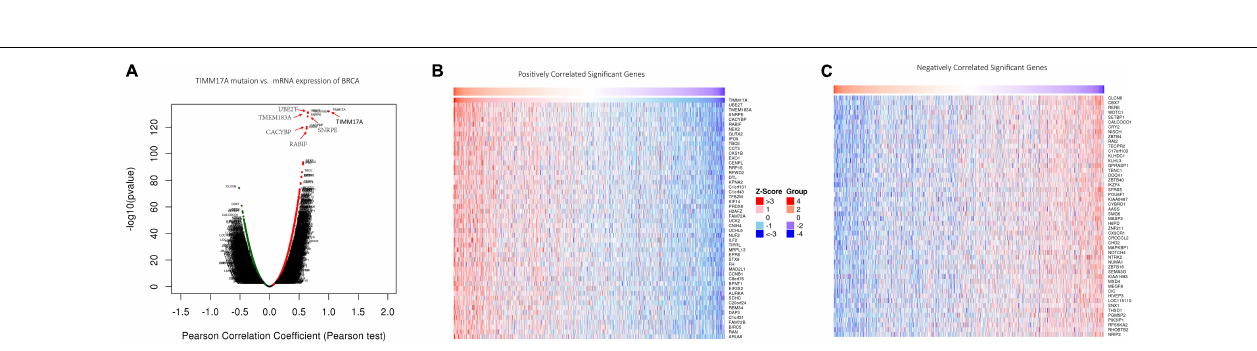
FIGURE 6 | Genes differentially expressed in correlation with TIMM17A expression among breast carcinoma patients (LinkedOmics). (A) Pearson’s correlation analyses to assess the association between TIMM17A expression and that other genes differentially expressed in BRCA. (B,C) Heat maps showing genes positively and negatively correlated with TIMM17A expression in BRCA (TOP 50). Red indicates positively correlated genes and green indicates negatively correlated genes.